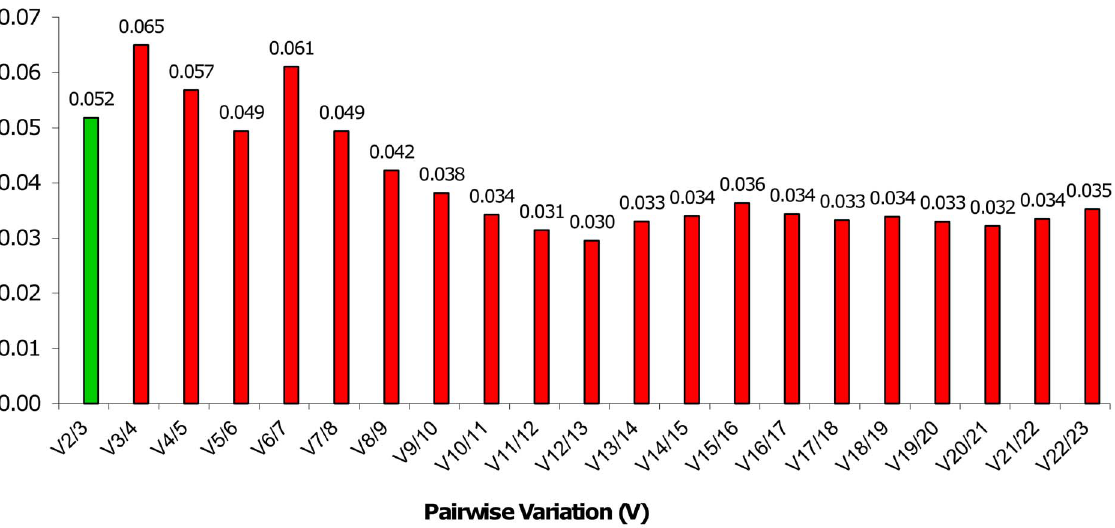
Figure 4. Pairwise variation (V) between the normalization factors (NFn and NFn + 1) to determine the optimal number of reference genes. V2/3 represents the pairwise variation between the NF values estimated for the two genes YLS8 and DRH1 and the NF values estimated for the three genes, YLS8, DRH1 and TIP41, and adding all 23 genes in the same way.